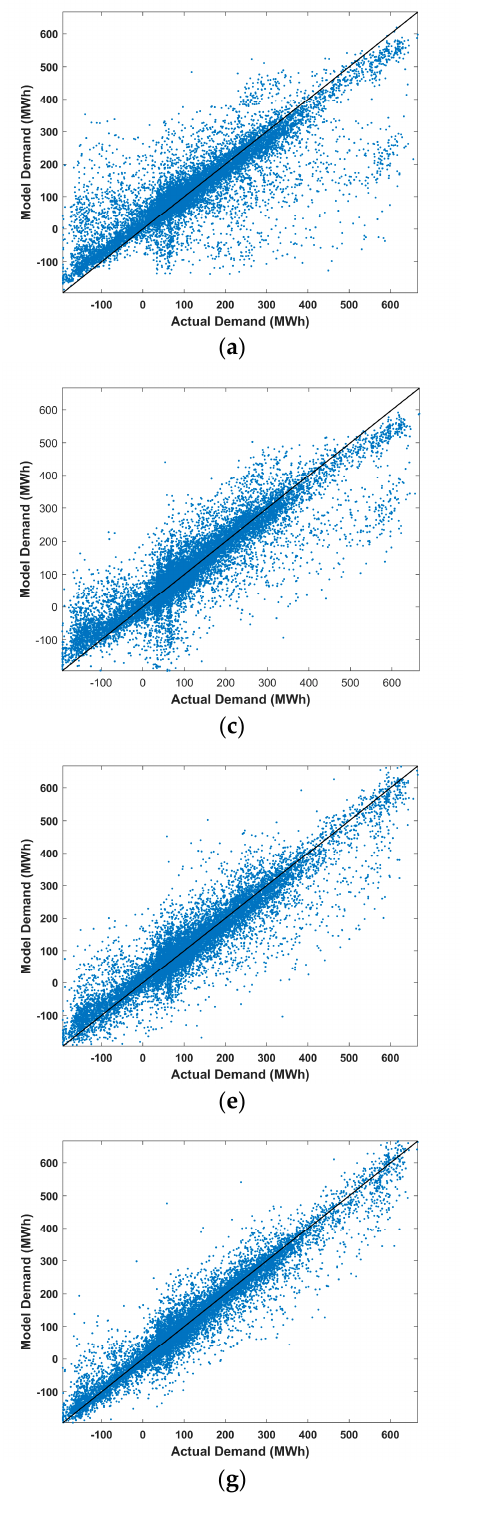
Figure 14. Parity plots of actual vs. predicted energy demand for the training dataset. ( a ) “Base case: no pricing used as inputs” L-ARX regression model; ( b ) one-step L-ARX regression model; ( c ) two-step L-ARX regression model; ( d ) one-step N-ARX regression model; ( e ) two-step N-ARX regression model; ( f ) “base case: No pricing used as inputs” N-ARXnet model; ( g ) one-step N-ARXnet model; ( h ) two-step N-ARXnet